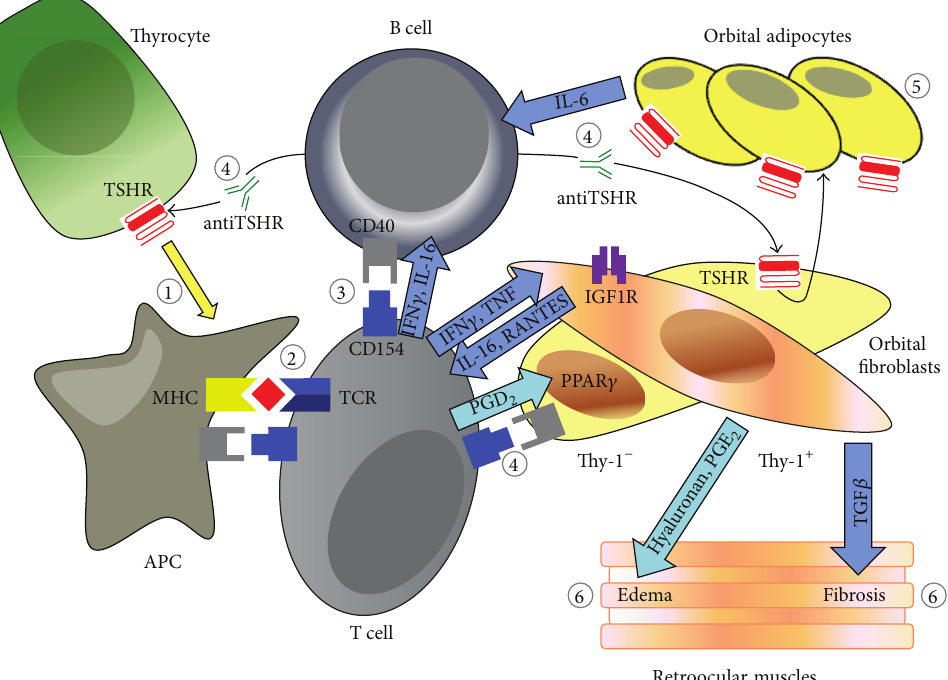
Figure 1: Immunopathogenesis of GO, highlighting the role of counterplay in the orbit between adipocytes, orbital fibroblast, and immunocompetent cells (lymphocytes T and B and macrophages) (adapted from a book chapter with the permission of Professor J.